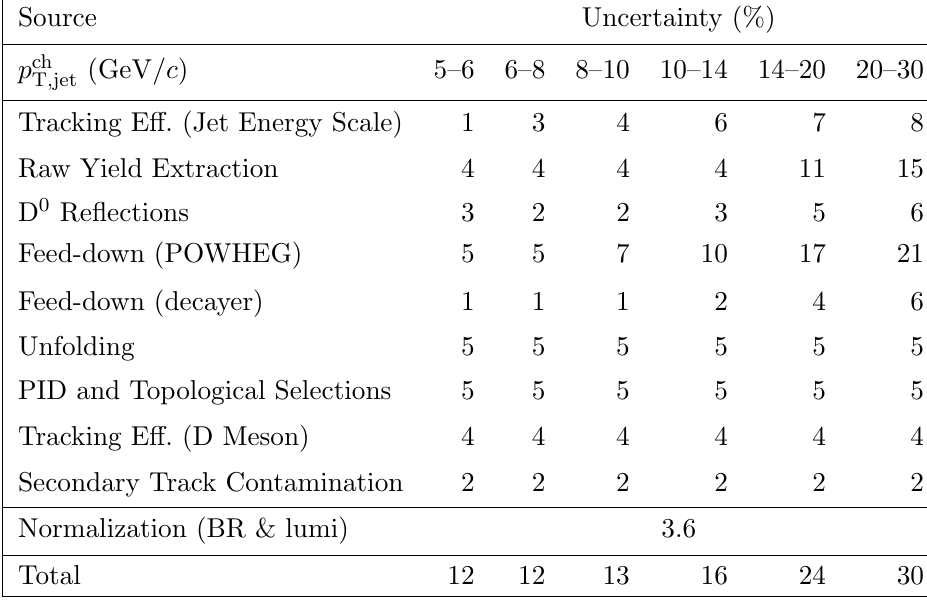
Table 1 . Summary of systematic uncertainties as a function of p ch